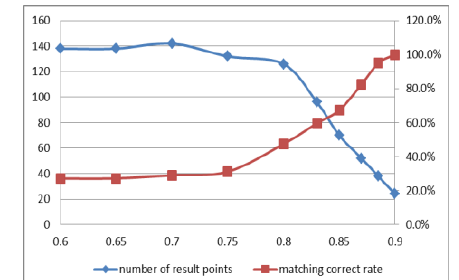
Figure 1 threshold for correlation coefficient, blue line for number of result points, red line for matching correct rate. The x-axis for threshold of correlation coefficient, the principal